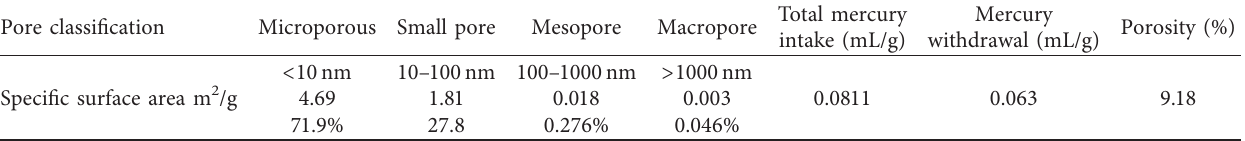
Table 1: Pore distribution of coal.